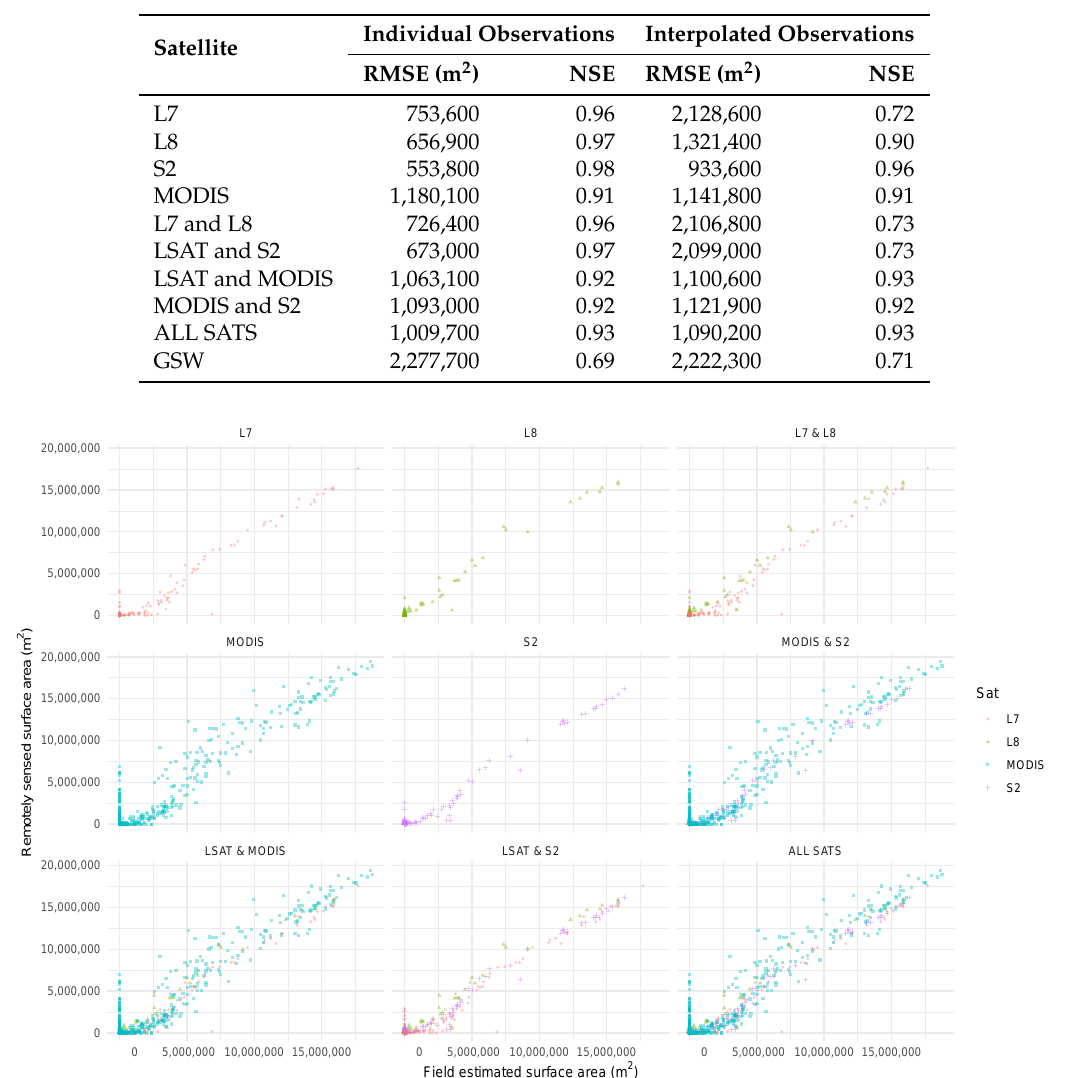
Figure 11. Scatterplot of remotely sensed flooded areas and ground truth data from each sensor and multi-sensor combinations